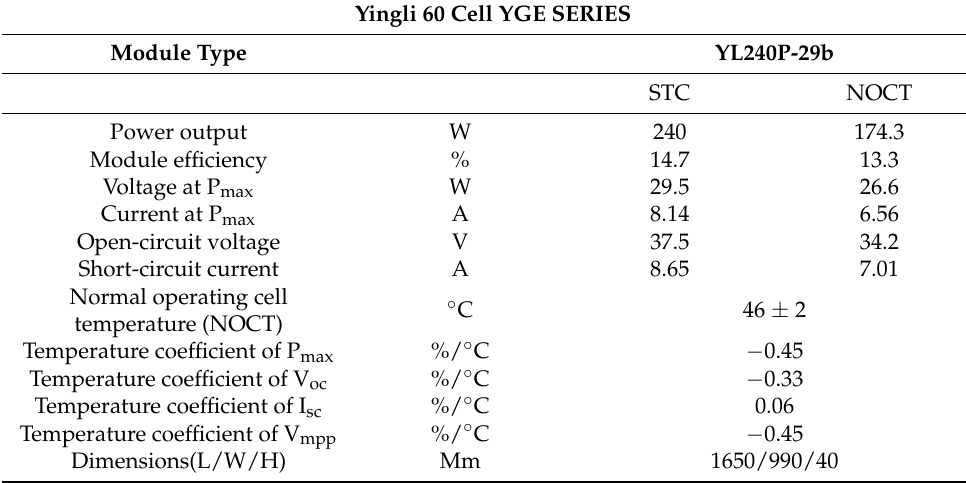
Table A1. Technical data of the PV modules.